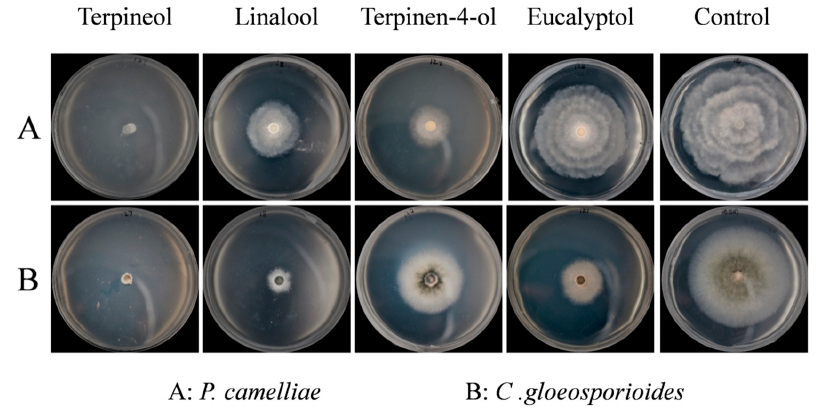
Figure 4. Fumigation activity of five mainly constituents on mycelial growth of P. camelliae ( A ) and C. gloeosporioides ( B ) at 200 μ L/L air of concentration after 5 days, respectively.